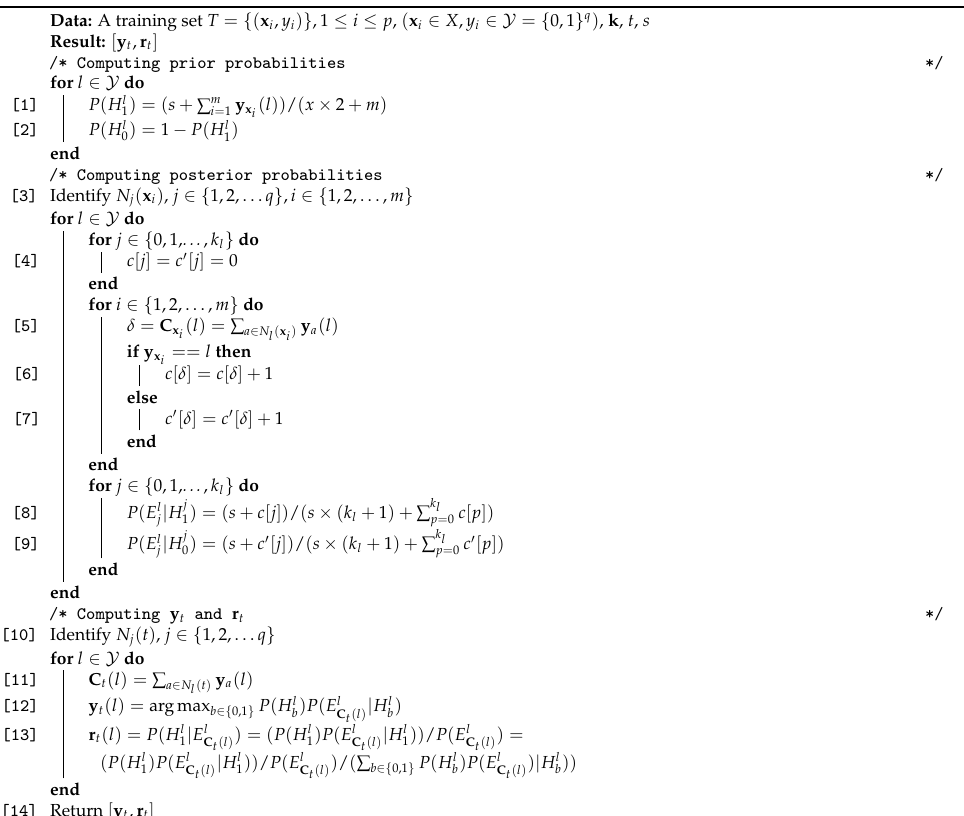
Algorithm 1: ML-k’sNN: Multi-label k’s nearest neighbors algorithm.